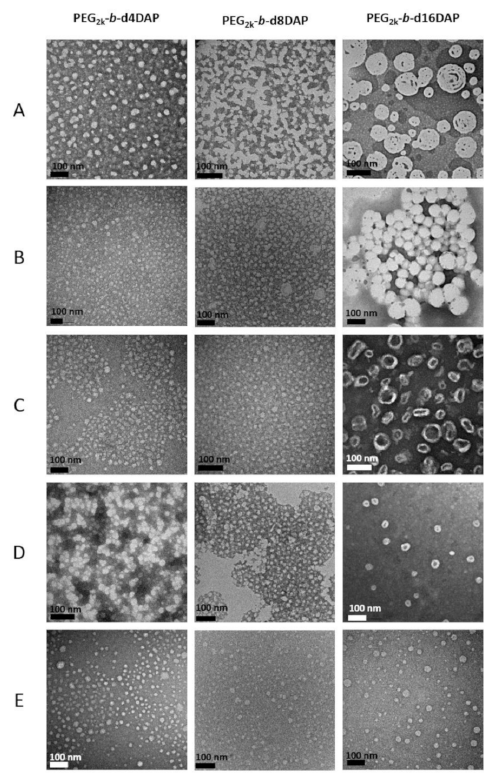
Figure 2. TEM images of PEG 2k - b -dxDAP self-assemblies prepared by microfluidics at different experimental conditions (aqueous/organic phase ratio) according to Table 3: ( A ) (60/40); ( B ) (70/30); ( C ) (80/20); ( D ) (90/10); and ( E )